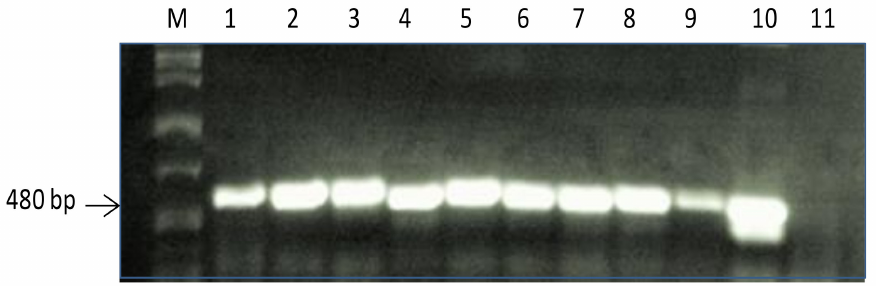
Figure 2. PCR analysis of PR10a faba bean: lane M DNA Molecular weight marker, lanes 1–9 transgenic faba bean plants, lane 10 plasmid DNA, lane 11 non-transformed control plants. The size of the amplified fragment is 480